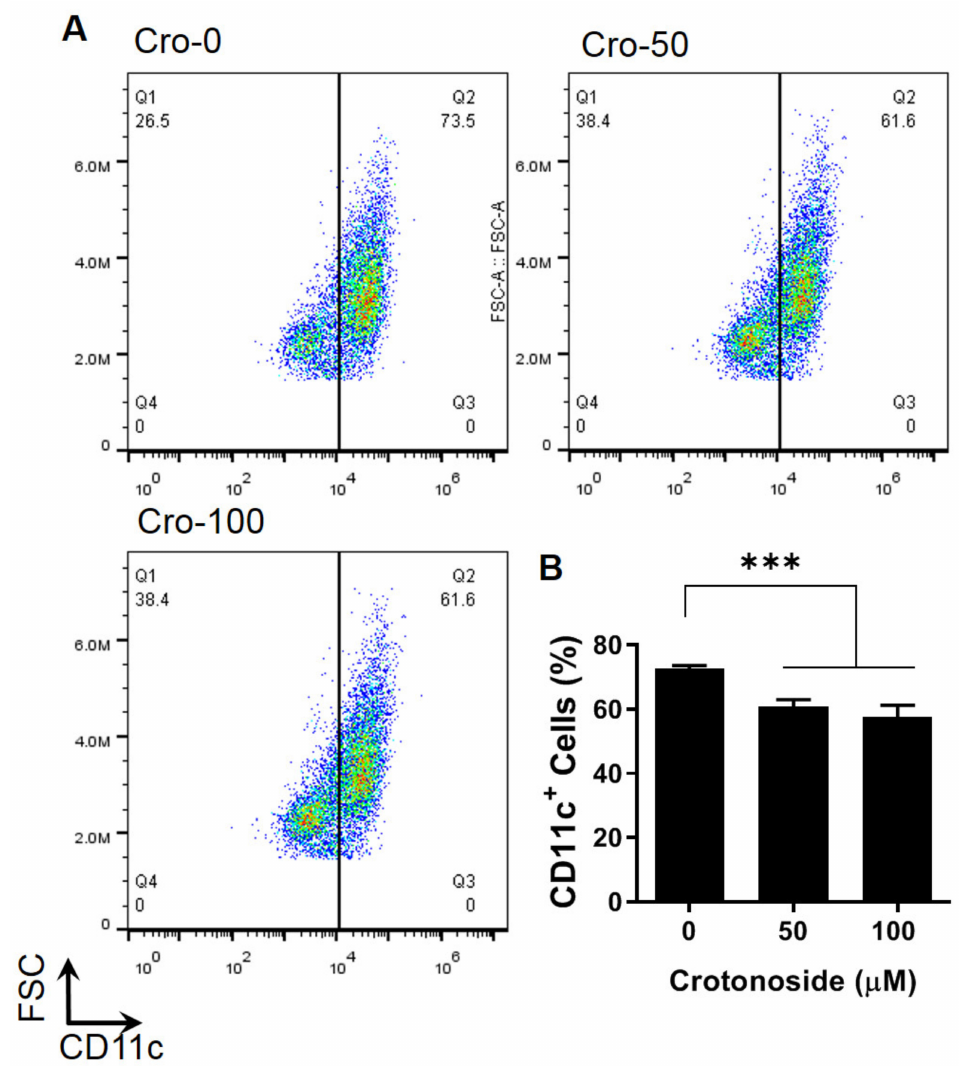
Figure 6. Reduced di ff erentiation of CD11c + bone marrow derived dendritic cells (BMDCs) due to crotonoside treatment. ( A ) The bivariate graphs of BMDCs of CIA mice cultured with the indicated concentration of crotonoside followed by evaluation of CD11c + expressions. ( B ) The mean ± SD of the experimental triplicates are presented in the bar graph. Experiments were repeated three times independently. *** p < 0.001 versus 0.1% DMSO-treated mock group, as determined by a one-way ANOVA with Dunnett